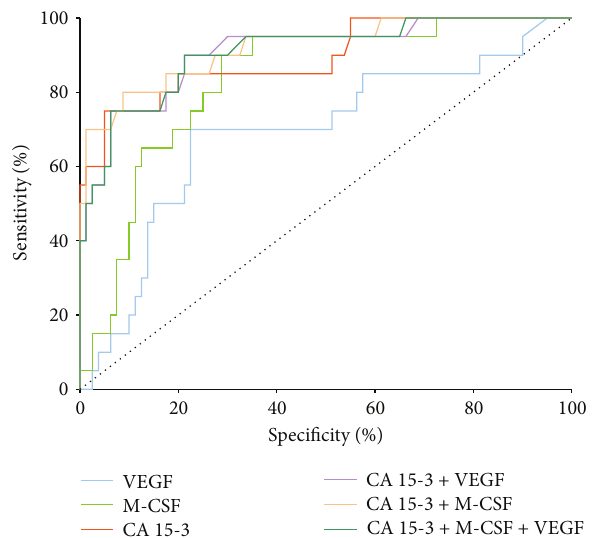
Figure 5: Diagnostic criteria of ROC curve for tested parameters and in combination with CA 15-3 in stage IV of